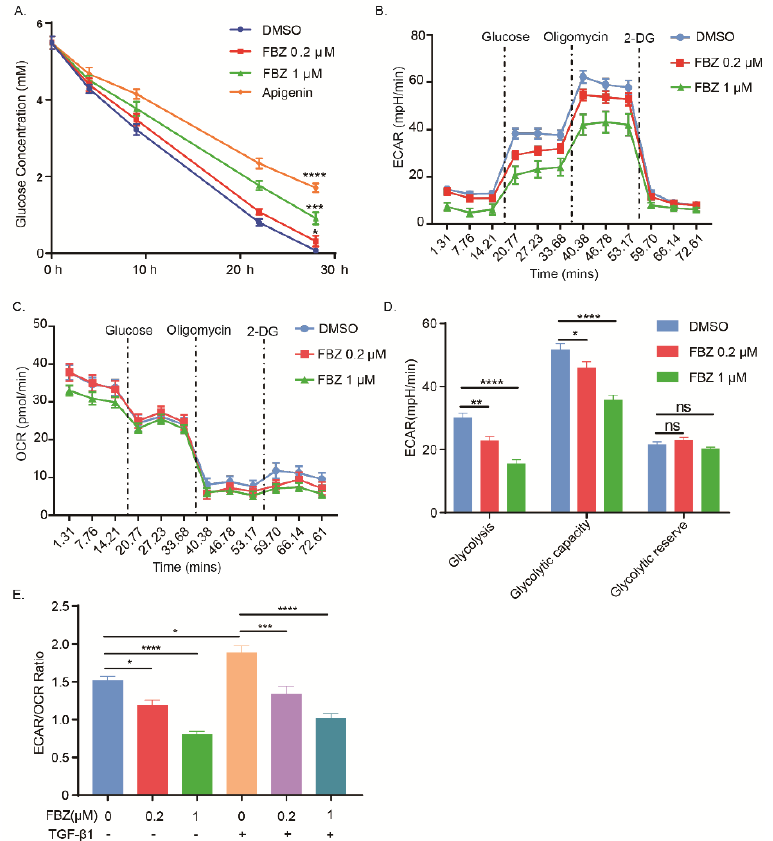
Figure 4. Fenbendazole inhibited glucose metabolism in fibroblasts. ( A ) IMR-90 cells were starved for 2 h in a glucose-free medium before being treated with FBZ (concentrations as indicated) or 50 μ M apigenin (as positive control). Glucose concentration in culture supernatants was determined by glucose oxidation assay using a GO assay kit (solarbio) ( n = 3, mean + SEM). ( B ) Analysis of extracellular acidification rate (ECAR) in IMR-90 cells treated with FBZ at indicated concentrations for 4 h. Cells were treated with glucose, oligomycin A, and 2-Deoxy-D-glucose (2-DG) at indicated time ( n = 6, mean + SEM). ( C ) Corresponding cellular oxygen consumption rate (OCR) from ( B ). ( D ) ECAR attributed to glycolysis, glycolytic capacity, and the glycolytic reserve was calculated from ( B ). ( E ) Calculated ECAR/OCR ratio in response to glucose addition. * p < 0.05, ** p <